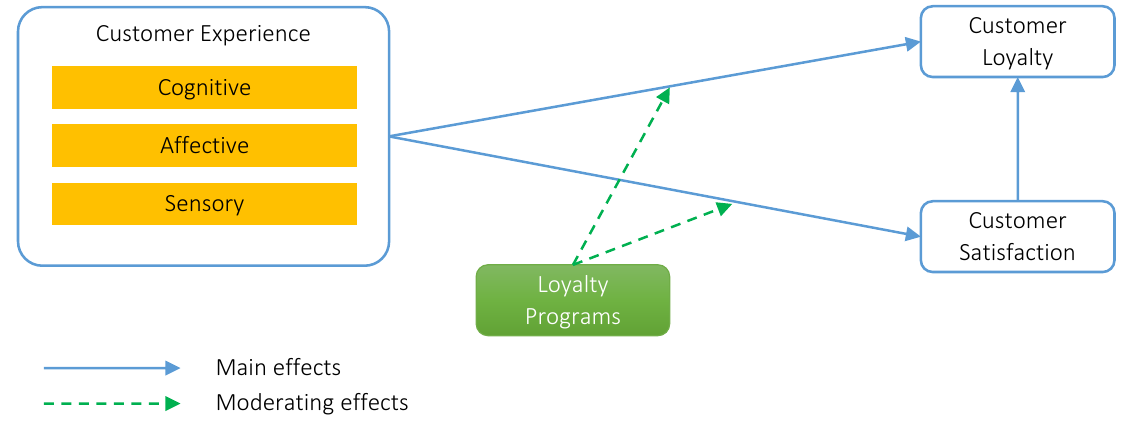
Figure 1. Conceptual